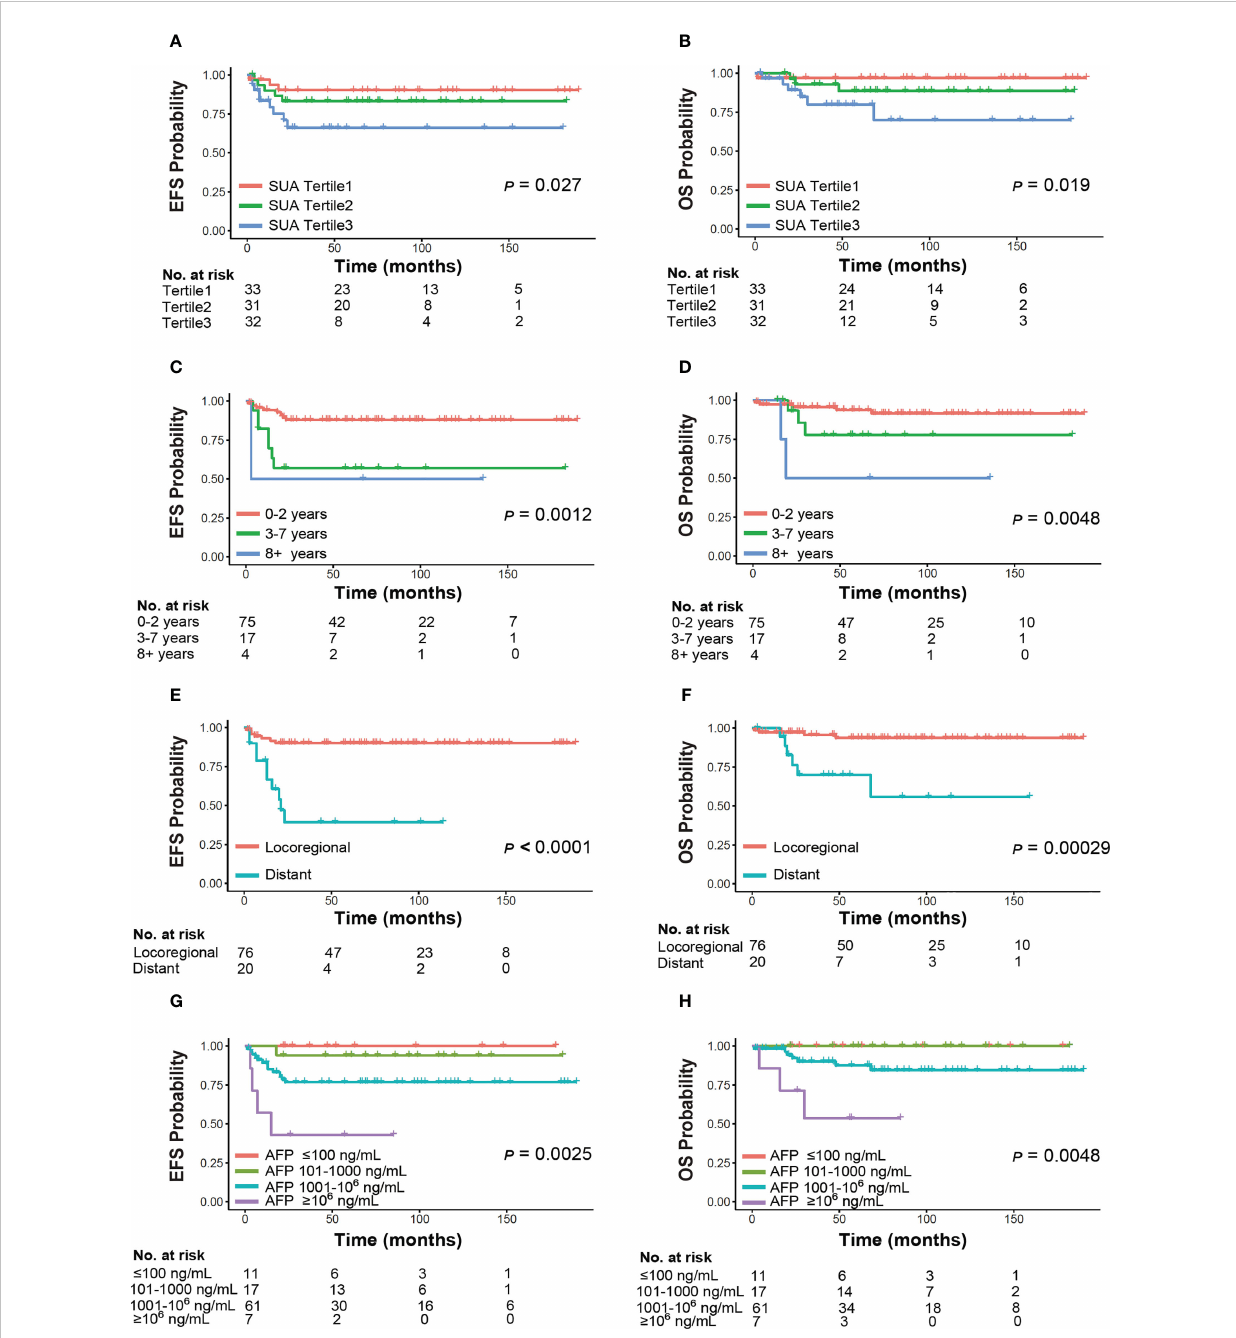
FIGURE 4 Event-free survival and overall survival by clinical characteristics of HB. Panels demonstrate subgroup analyses by (A, B) SUA, (C, D) age, (E, F) metastases status, (G, H) AFP. SUA and AFP levels were examined post-neoadjuvant chemotherapy. Abbreviations: SUA, serum uric acid; AFP, a